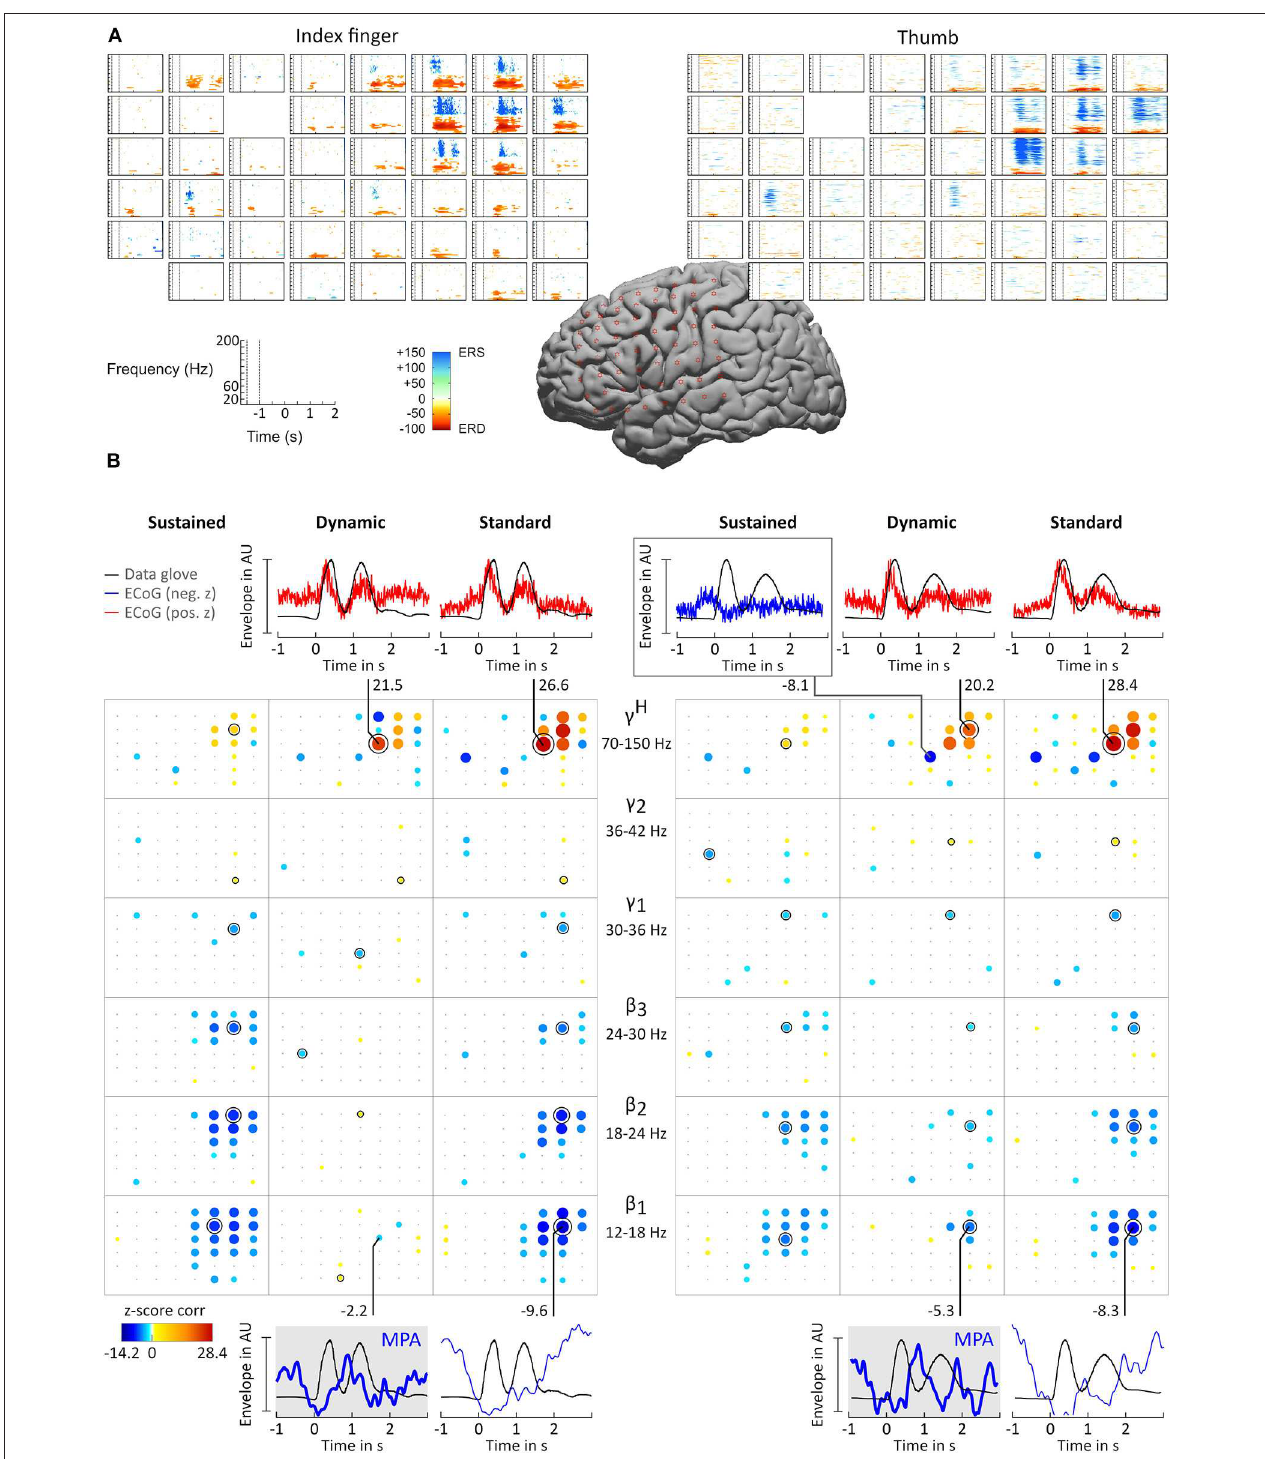
FIGURE 3 | Results for subject BP. (A) ERD/ERS time-frequency maps. The plots show, topographically arranged (8 × 8 grid), significant ERD and ERS activity plots for index finger (left) and thumb (right). Electrode locations are marked by star symbol on standard brain. (B) Correlation analysis and MPA. Significant z-score transformed Pearson correlation coefficients, computed between corresponding digit trajectory and ECoG envelope components, are displayed for index finger (left) and thumb (right) movements. Z-scores are topographically arranged for each condition (columns, sustained, dynamic, and standard) and frequency band